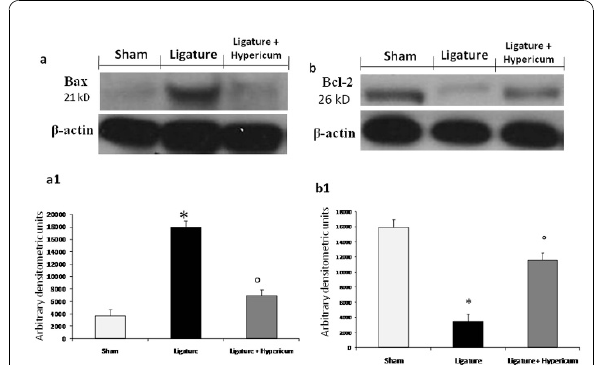
Figure 7 Western blot analysis was performed on gingivomucosal tissue collected 8 days after injury . Basal level of Bax was present in the tissue from-sham operated rats (a, a1). Bax band is more evident in the tissue from ligature treated rats (a, a1). The Bax band disappeared in the tissue from ligated rats that received Hypericum (a, a1). Moreover a basal level of Bcl-2 was present in the tissue from sham-operated rats (b, b1). The Bcl-2 band disappeared in the tissue from rats subjected to ligation (b, b1). The Bcl-2 band is more evident in the tissue from ligated rats that received Hypericum (b, b1). The immunoblot in (a and b) represents one tissue of the 5-6 analyzed. The results in (a1 and b1) are expressed as mean 7 s.e.m. from 5-6 tissues. *P < 0.01 vs non- ligated; °P < 0.01 vs